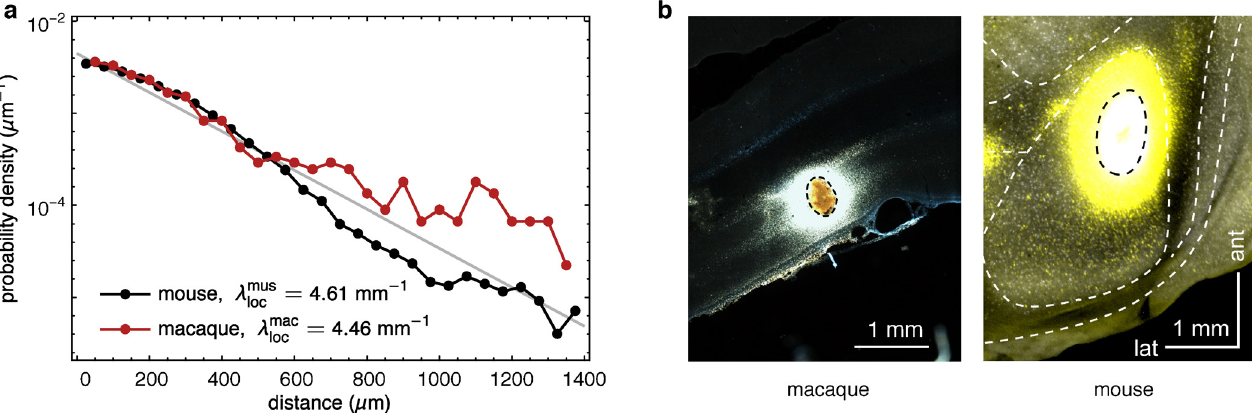
Fig 11. Decay rates of intrinsic labeling in mouse and macaque. Intrinsic retrograde labeling in macaque and mouse show a common, exponential decay of the connection probability with distance in the gray matter measured from the edge of the pickup zone. (a) Probability density function of neuron counts as a function of the distance from the edge of the pickup zone. The 95% confidence intervals of the decay rates are (4.58, 4.65) mm − 1 for mouse and (4.14, 4.80) mm − 1 for macaque. The mouse decay rate is estimated for the interval up to 900 μ m using a generalized linear model with a Poisson family and log link. (b) Photographs of injection sites in area V1 in macaque (horizontal section) and mouse (tangential section). The black dashed line corresponds to the edge of the pickup zone in both panels.